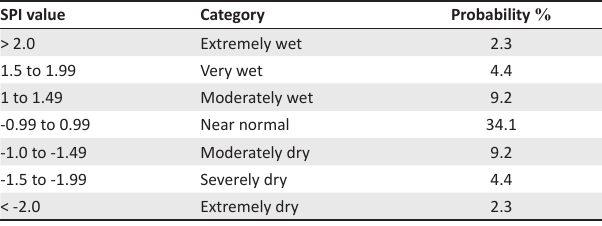
TABLE 2: Standardised precipitation index